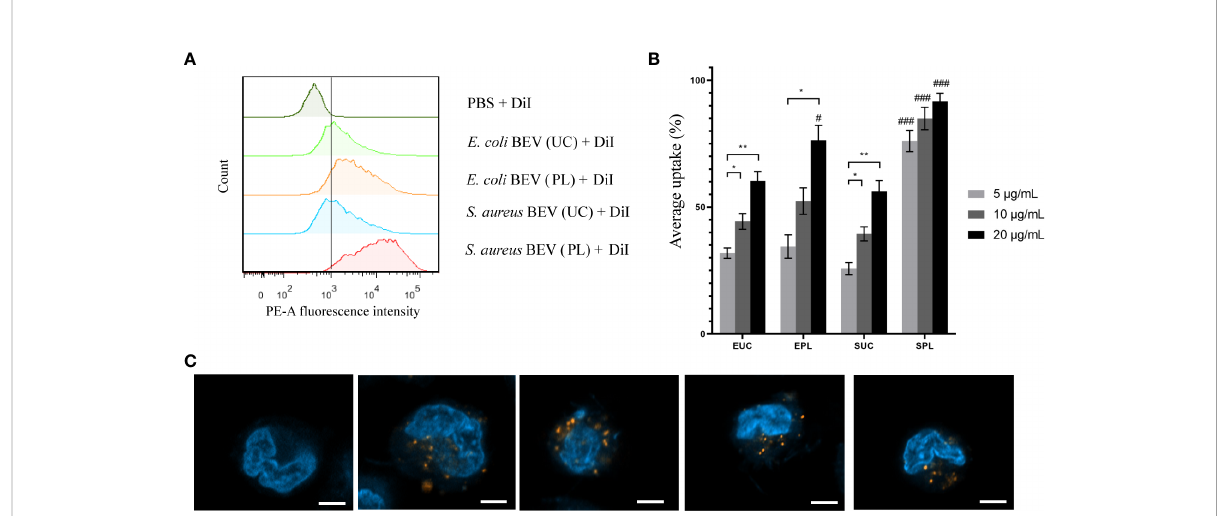
FIGURE 5 BEVs show successful uptake within THP-1 cells. (A) The phycoerythrin (PE-A) channel fl uorescence intensity after incubation of cells with DiI- labeled BEVs in a fl ow cytometry measurement. The dashed line separates PE-A channel positive and negative cells. (B) Average percentage uptake of fl uorescently labeled BEVs at different concentrations (5, 10 and 20 m g/mL) inside THP-1 cells. EUC, E. coli BEV isolated by UC; EPL, E. coli BEV isolated by PL; SUC, S. aureus BEV isolated by UC; SPL, S. aureus BEV isolated by PL. Signi fi cant differences between different BEV concentrations are indicated by asterisks: *p < 0.05; **<0.01. Signi fi cant differences compared BEVs isolated by different method among the same concentrations are indicated by hash sign: # p < 0.05; ### p < 0.001. (C) Confocal microscopy images of internalization of BEVs into THP-1 cells. PBS-treated THP-1 cells served as the negative control. (Left to right: negative control, BEVs derived from E. coli isolated by UC and PL, and BEVs derived from S.aureus isolated by UC and PL.) Red, DiI-stained BEVs; blue, DAPI-stained nucleus of THP-1 cells. Scale bar: 5 m